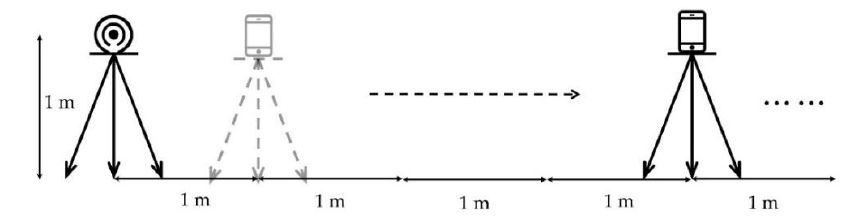
Figure 5. Schematic of data acquisition experiment.